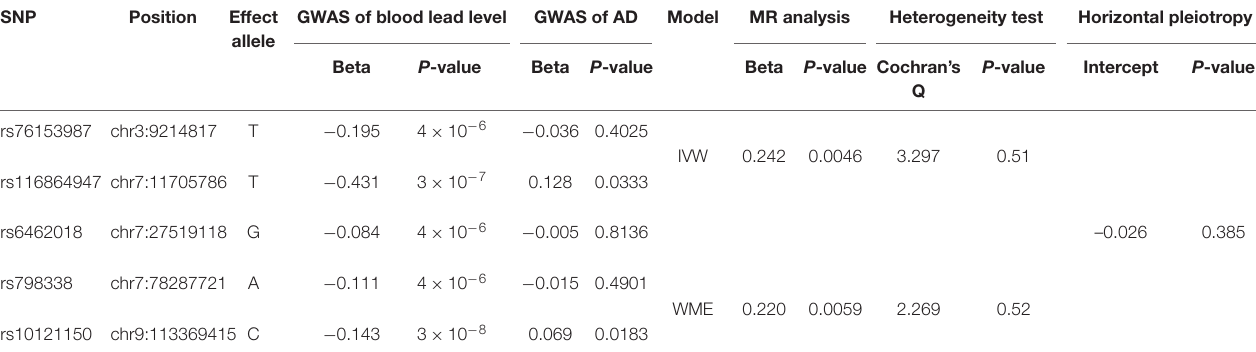
TABLE 2 | The causality of blood lead level and AD risk by two-sample MR analysis using the data of EFO_0000249. SNP